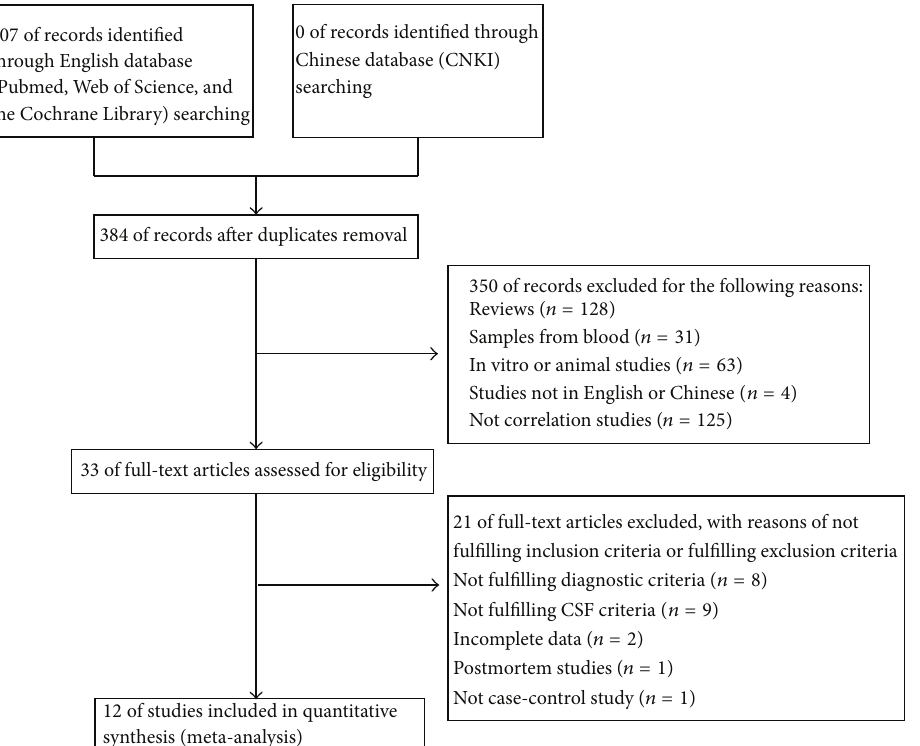
Figure 1: Flow diagram of the study selection process used for the meta-analysis of 𝛼